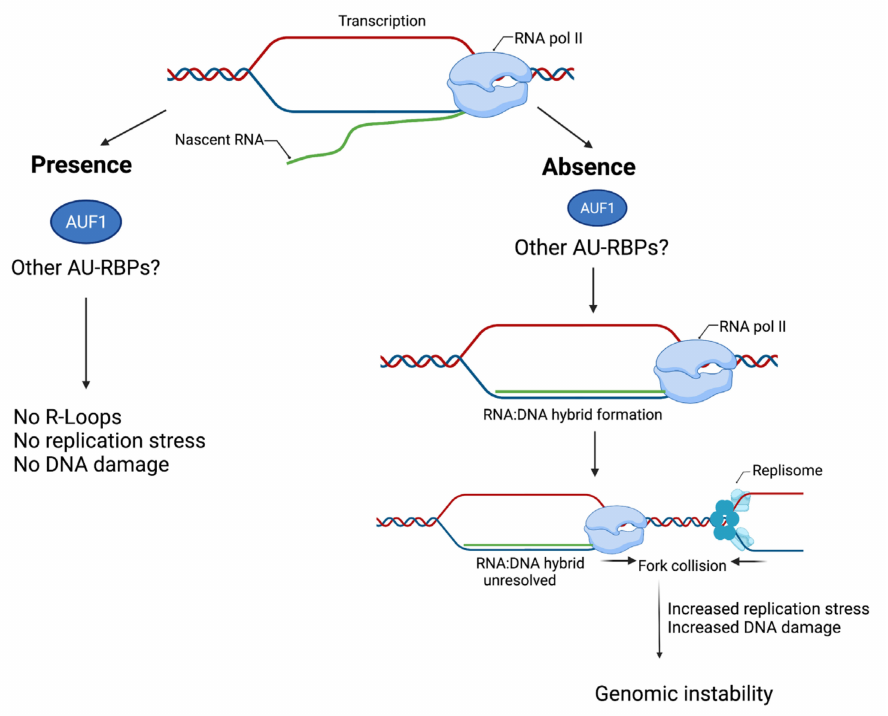
Figure 5. Potential roles of AU-RBPs in preventing R-loop formation in response to replication stress. During the process of transcription by RNA polymerase II (RNA pol II), the nascent RNA is prevented from hybridizing with the template strand DNA strand (RNA: DNA hybrid) in the presence of AUF1 and possibly other AU-RBPs. Therefore preventing the formation of R-loops that cause replication stress and DNA damage. In the absence of AUF1 and possibly other AU-RBPs the nascent RNA can hybridise with the template strand and displace the non-template strand into a long stretch of ssDNA forming an R-loop structure. Unresolved R-loops can cause transcription and replication fork collisions, resulting in increased replication stress and DNA damage that compromise genomic